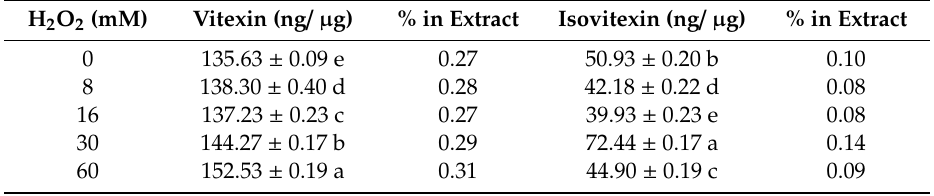
Table 5. Quantification of vitexin and isovitexin under different concentrations of H 2 O 2 in Ficus deltoidea var deltoidea plant. Means (± S.E.) with same letter do not differ significantly according to the Sheffer’s post hoc test at α = 0.05.